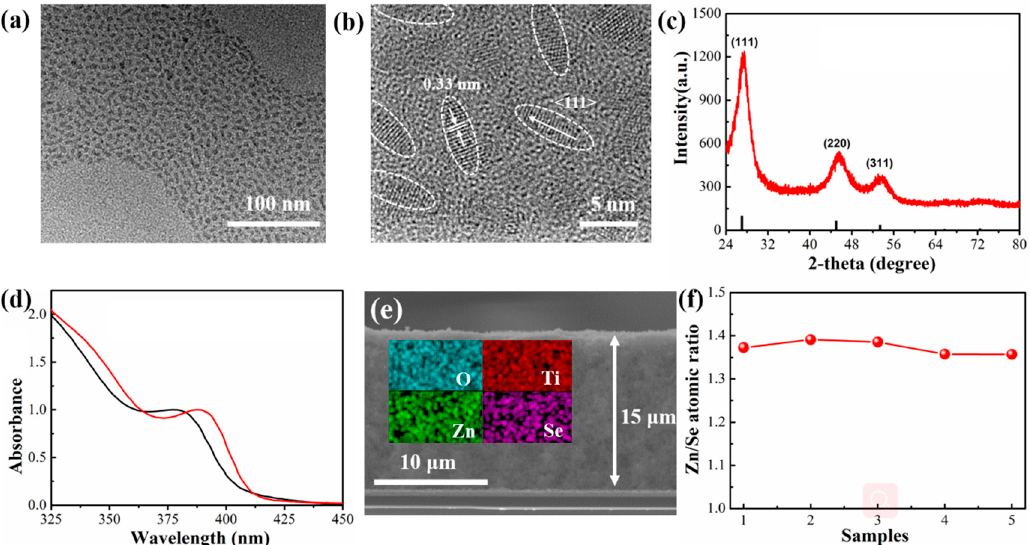
Figure 1. ( a ) TEM and ( b ) HRTEM images of ZnSe NRs. ( c ) XRD pattern of ZnSe NRs (in red); the line pattern in black gives the reflexes of the bulk zinc-blende ZnSe (JCPDS No. 37-1463). ( d ) UV-vis absorption spectra of ZnSe NRs before (black) and after (red) 3-MPA ligand exchange. ( e ) Cross-sectional SEM image of the TiO 2 / ZnSe NR film, with elemental distribution maps of O, Ti, Zn, and Se elements on its cross section provided as a colored inset. ( f ) Zn / Se atomic ratio for the ZnSe NRs (five samples were tested) determined by ICP–AES.